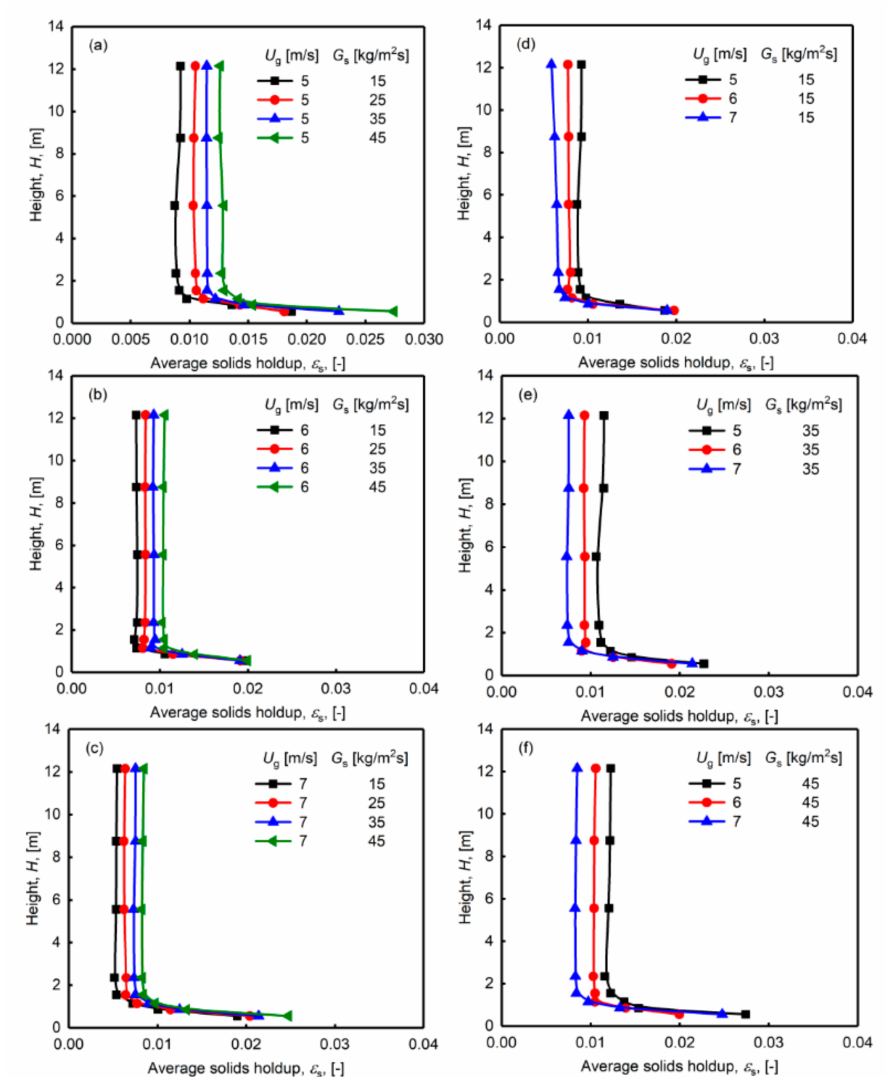
Figure 5. Axial distributions of the averaged solids holdup under various operating conditions. (( a – c ) represents the axial distribution of solids holdup under different solids circulation rates. ( d – f ) represents the axial distribution of solids holdup at different superficial gas